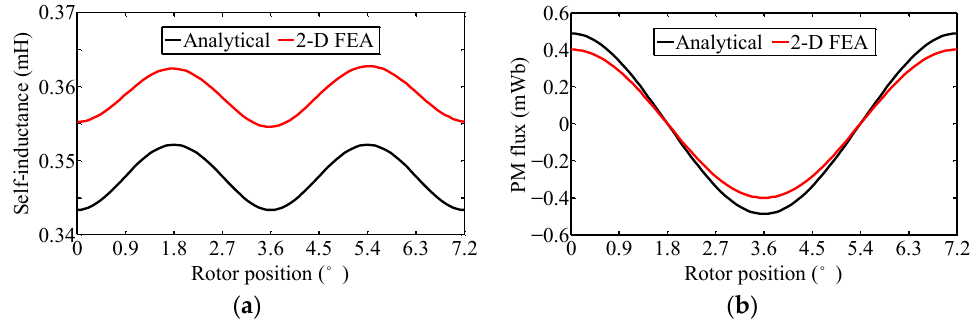
Figure 19. Comparison of self-inductance and PM flux by analytical method and 2-D FEA. ( a ) L aa of sub-motor1; ( b ) ψ pma of sub-motor1.